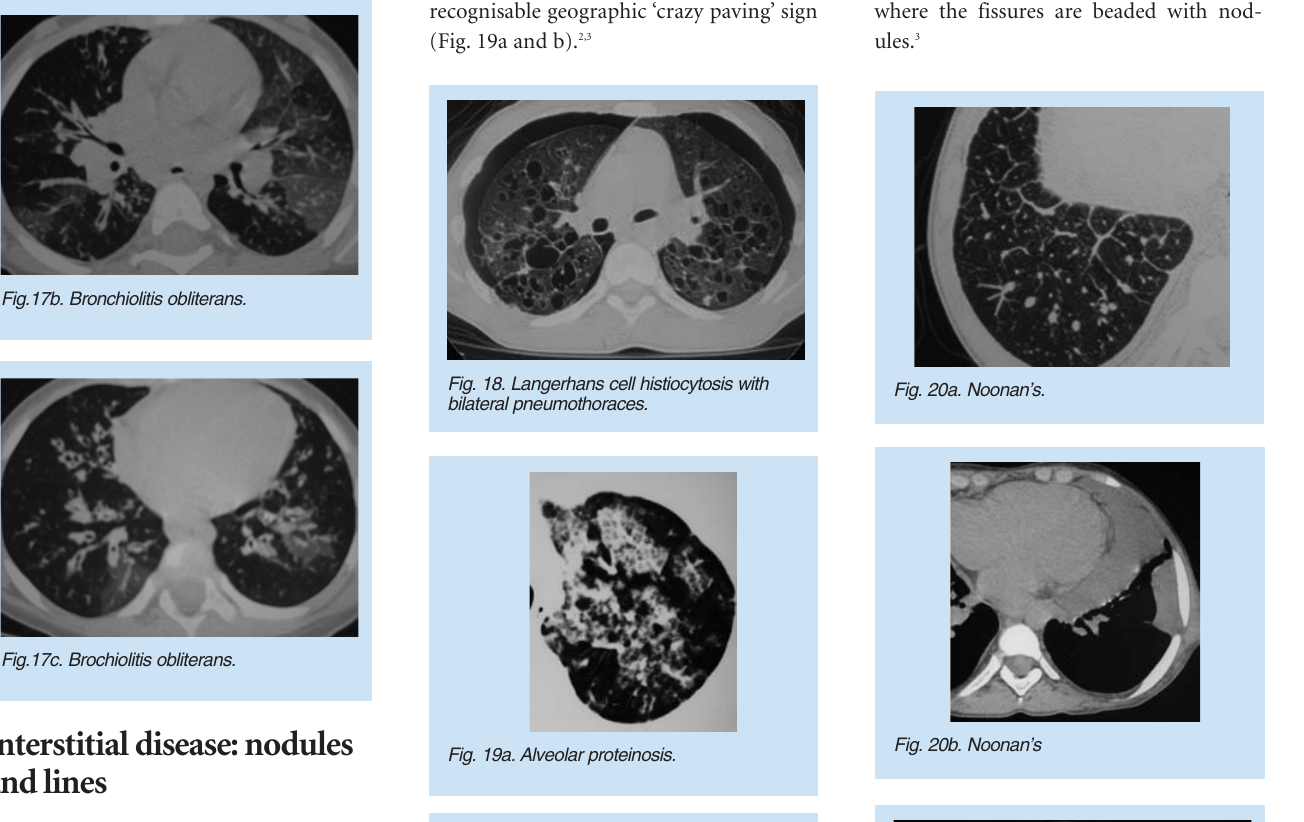
Fig. 19a. Alveolar proteinosis.